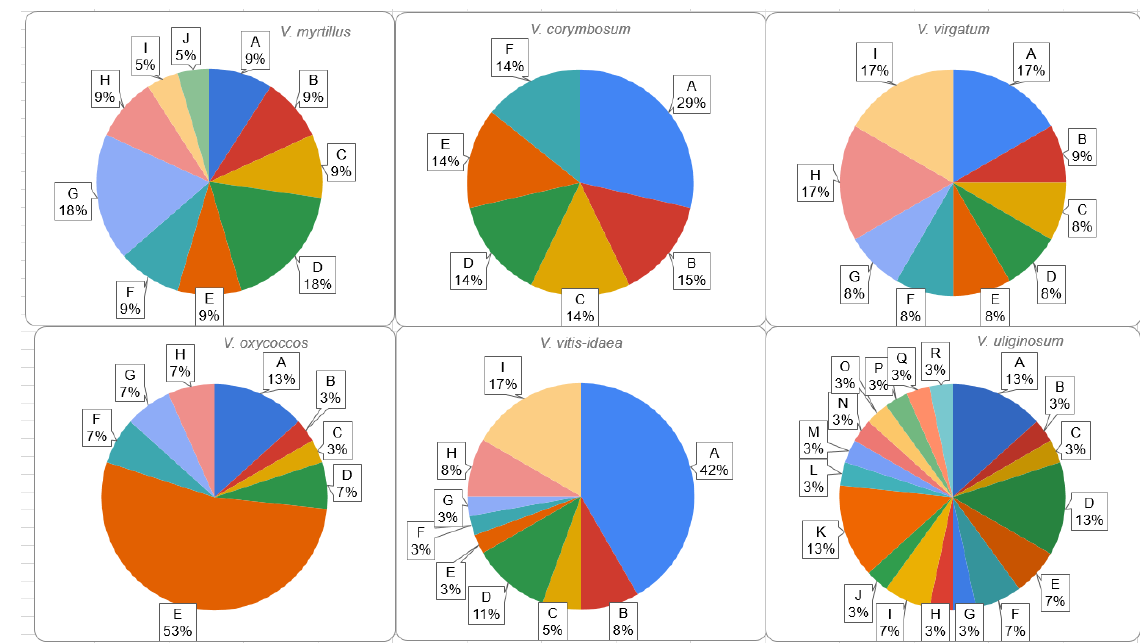
Figure 3. Frequencies of alleles of rolB/C -like gene in Vaccinium species.